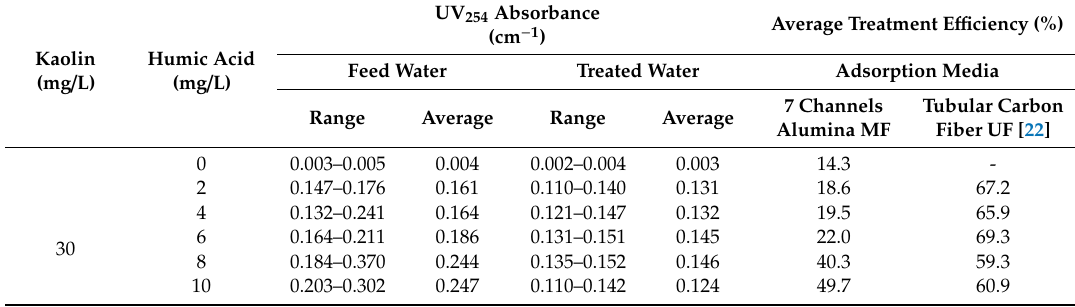
Table 4. Water quality and treatment e ffi ciency of dissolved organic matter (DOM) (UV 254 absorbance) in the hybrid process of 7-channel alumina MF (HC10) and PP beads for the e ff ect of humic acid concentration as compared with results of tubular carbon fiber UF (C005) membrane.